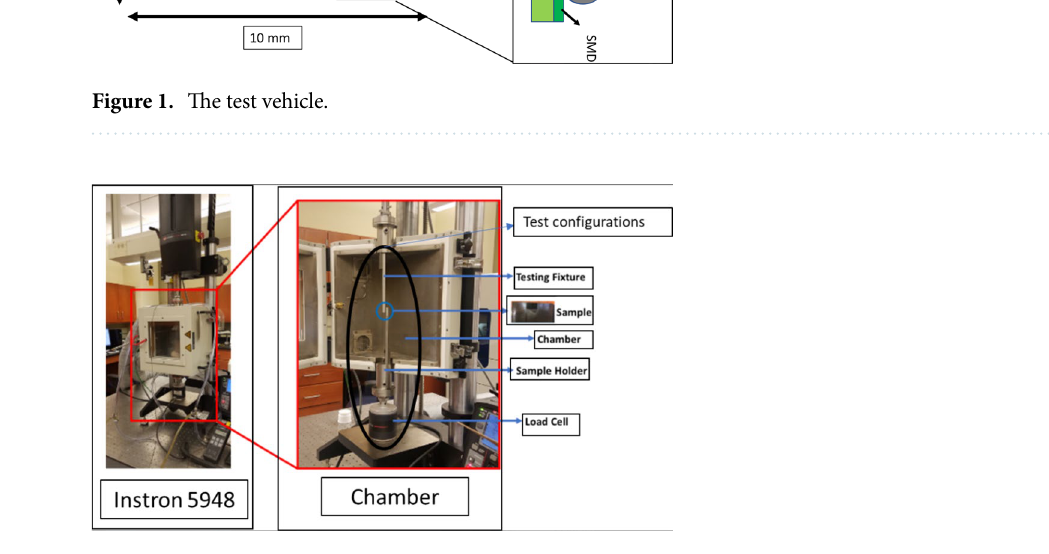
Figure 2. Intron testing machine and test